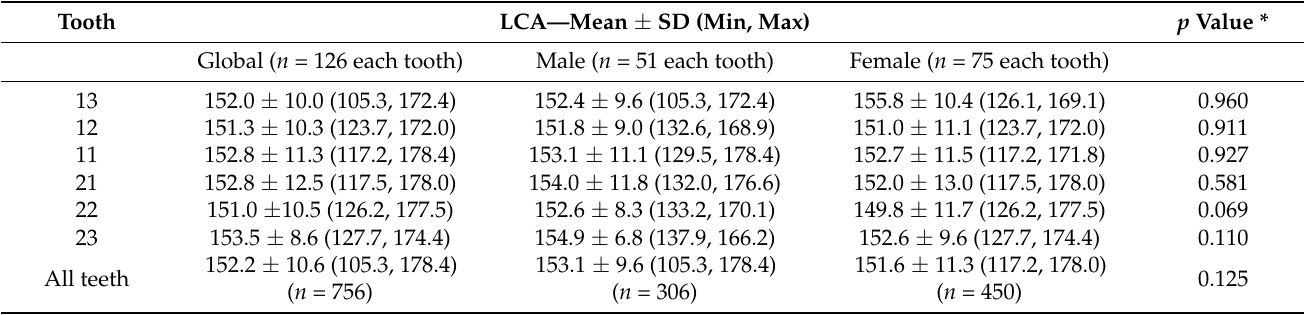
Table 4. LCA values—global and for the different